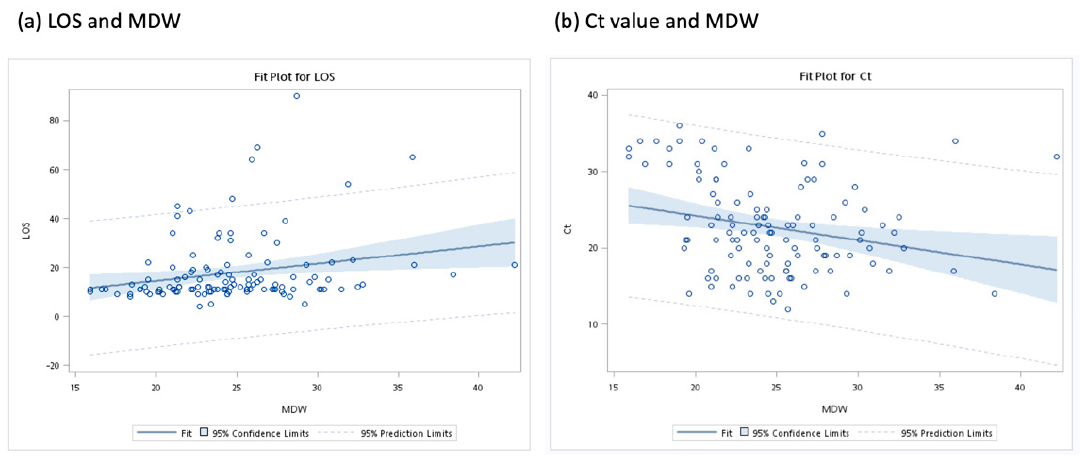
Figure 3. Validation study: ( a ) a positive correlation between length of stay for patients with COVID ‐ 19 and MDW; ( b ) a negative correlation between Ct value and MDW.